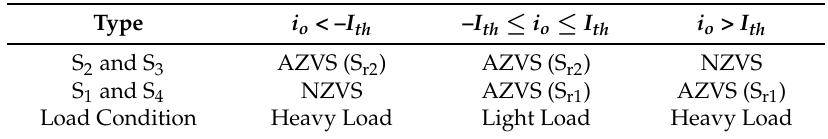
Table 1. Realization type of ZVS from zero load to full load.